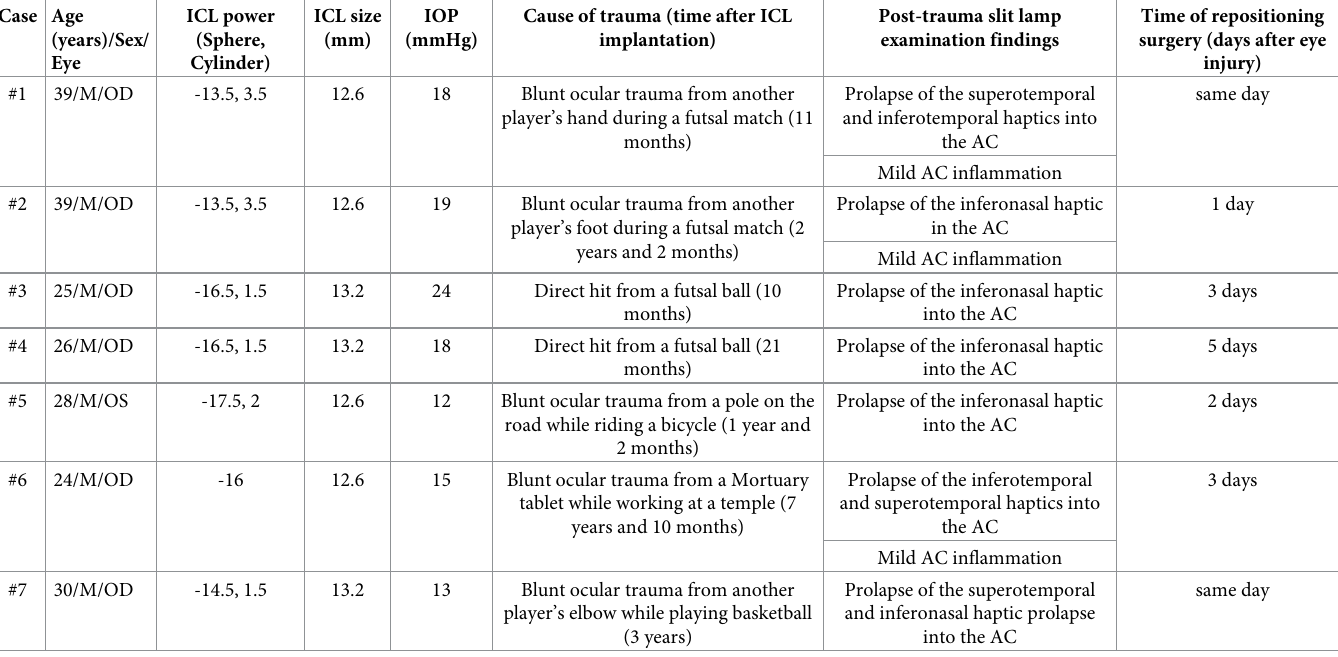
Table 1. Patient demographic information and cause of ocular